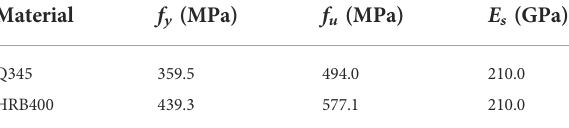
TABLE 4 Material properties of steel.